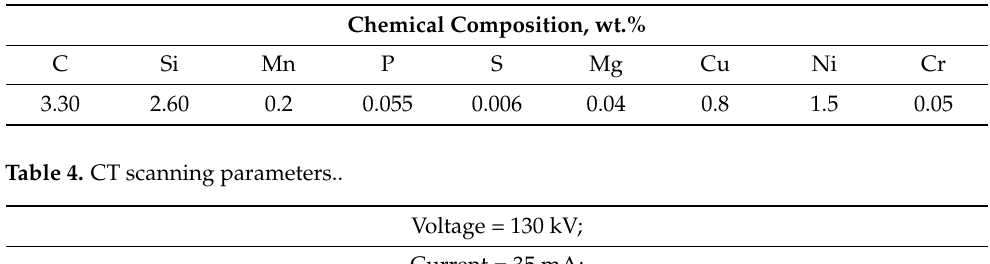
plates were placed vertically with the feeder on top, and were cast in green sand-dried